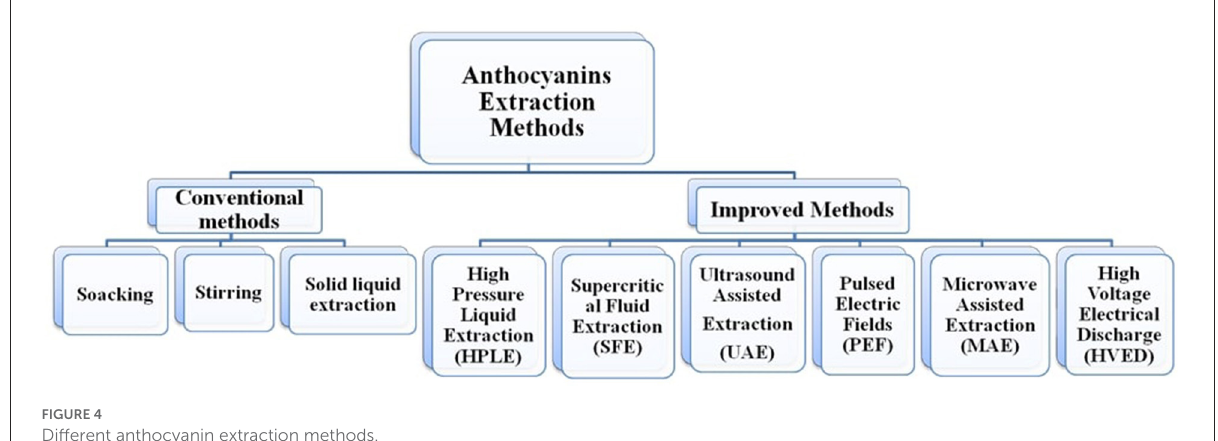
FIGURE4 Different anthocyanin extraction